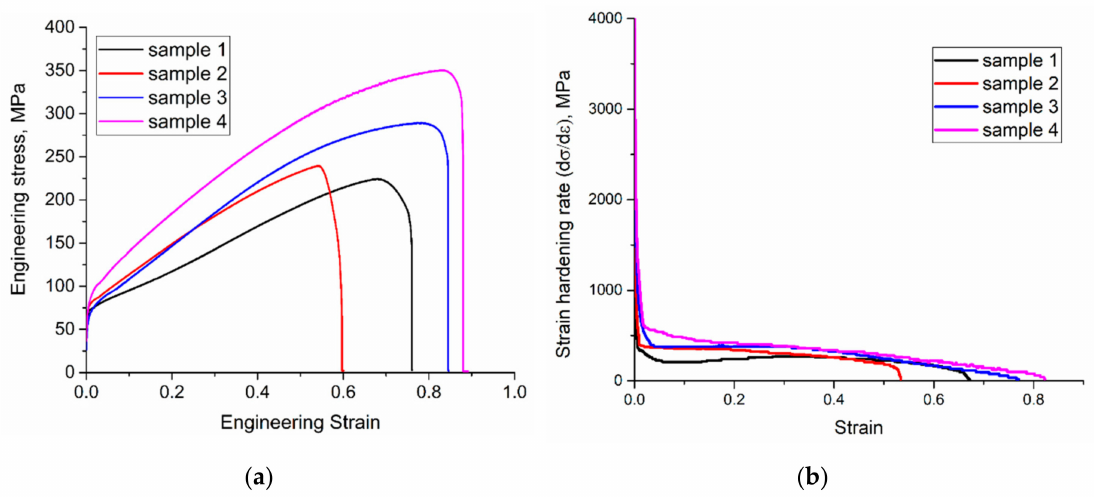
Figure 11. The “stress-strain” ( a ) and “strain hardening rate-strain” ( b ) curves obtained from tensile tests on the samples